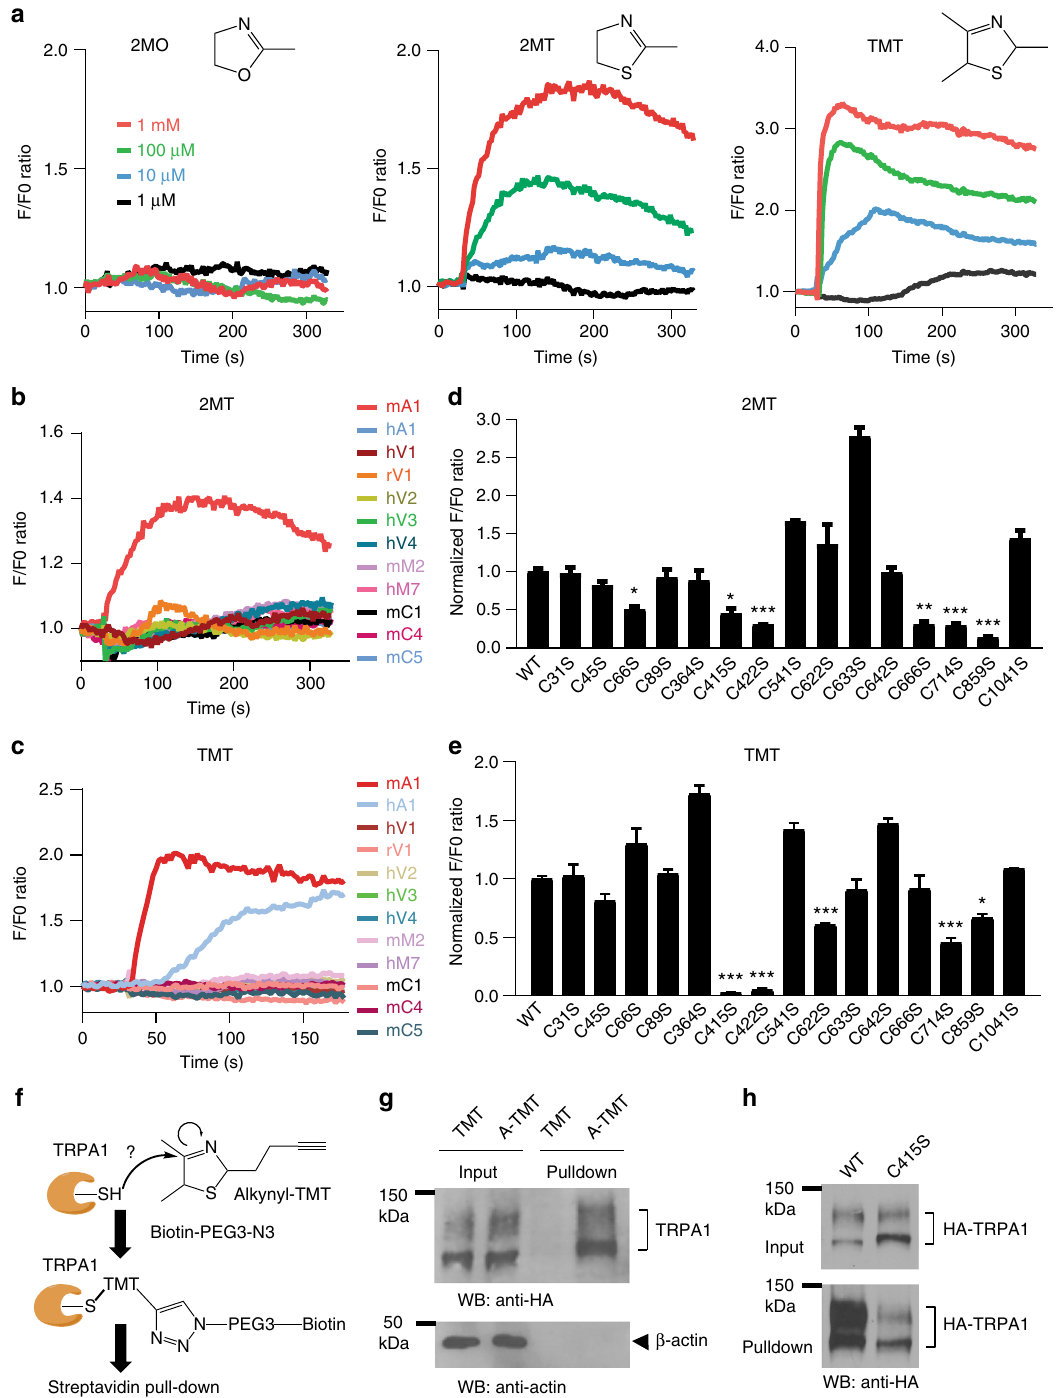
Fig. 5 Trpa1 acts as a chemosensor for 2MT/TMT. a Twenty-four hours after transfection of the Trpa1-P2A-mCherry construct, Ca 2 + imaging was performed in HEK293T cells upon exposure to 1, 10, 100, 1000 μ M of 2MO, 2MT, or TMT. b , c 2MT (100 μ M, b ) or TMT (50 μ M, c )-evoked Ca 2 + response curves of HEK293T cells after co-transfection of the mCherry plasmid with each of 12 constructs expressing different mammalian TRP channels (h human, r rat, m mouse). d , e Quantitative analysis of wild-type (WT) and mutant Trpa1 activities in response to 2MT (100 μ M, d ) or TMT (50 μ M, e ) by Ca 2 + imaging in transfected HEK293T cells. Y -axis, F/F0 ratio normalized to WT construct. Data are presented as mean ± SEM ( n = 3 biological replicates). Pairwise comparisons were made for each mutant Trpa1 to wild-type Trpa1 using two-way unpaired Student ’ s t -test. Multiple comparisons were controlled by Bonferroni correction with unadjusted P- value cutoff being 0.005 (***), 0.01 (**), and 0.05 (*). f A schematic of in vivo labeling of transfected HA-Trpa1 with alkynyl-TMT followed by biotin conjugation via click chemistry and streptavidin pull down. g , h Immunoblots showing that alkynyl-TMT (A-TMT), but not TMT, could pull down HA-Trpa1 ( g ), and that alkynyl-TMT could pull down C415S mutant less ef fi ciently than wild-type HA-Trpa1 ( h ) from transfected HEK293T